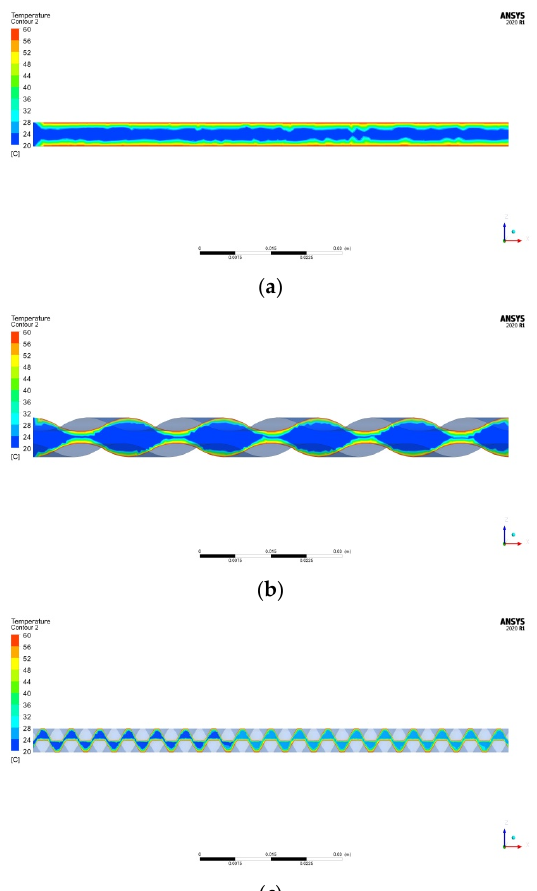
Figure 7. Temperature distribution paths: ( a ) flat heat exchange plate; ( b ) chevron heat exchange plate; ( с ) plate with conical stamping.